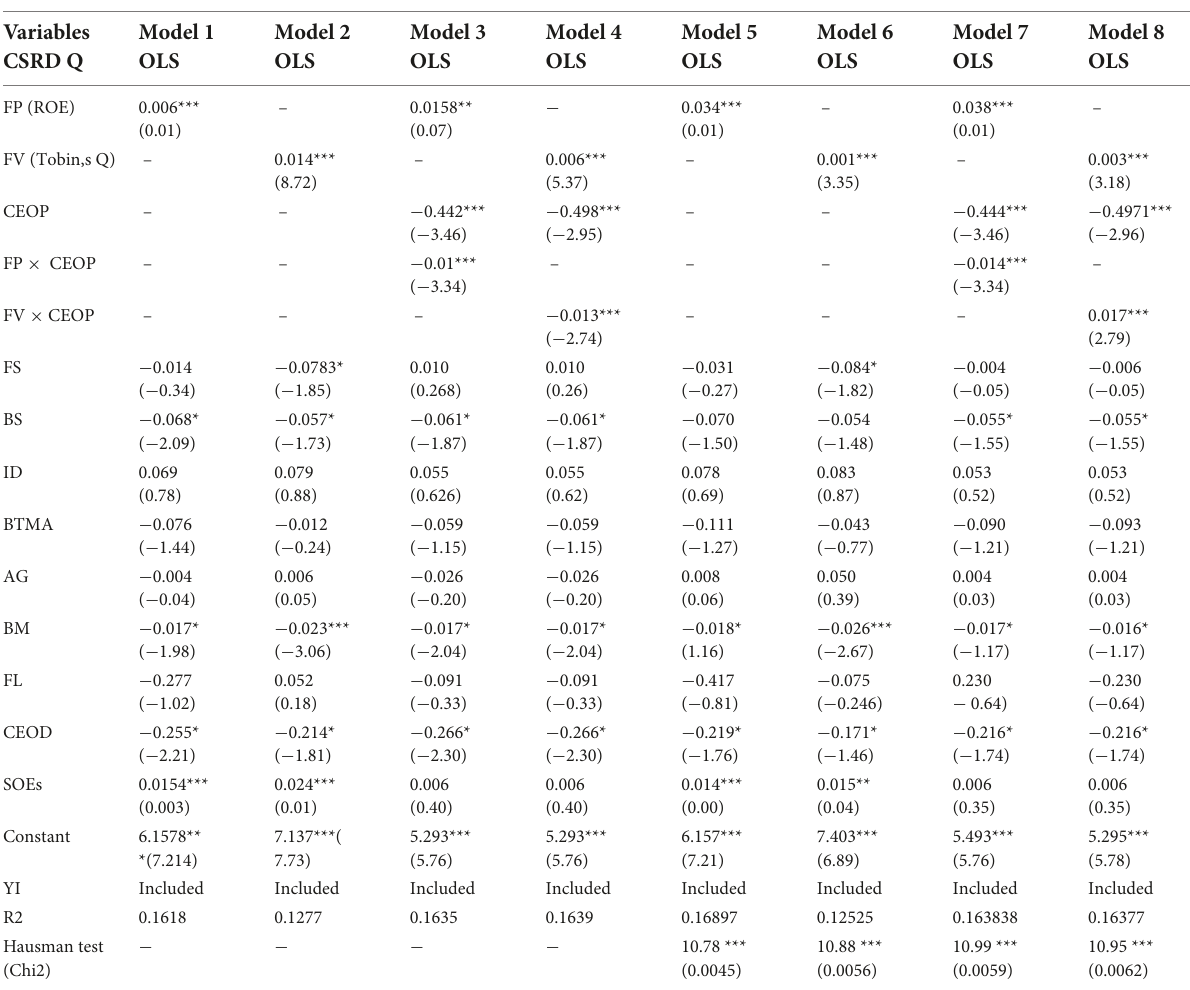
TABLE 5 Results with fixed effects and random effects (robustness